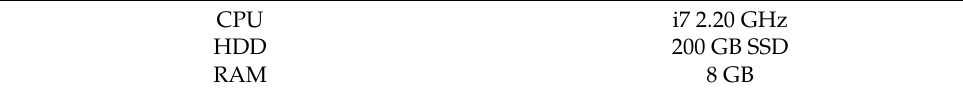
Table 1. Test Table 1. Test environment.